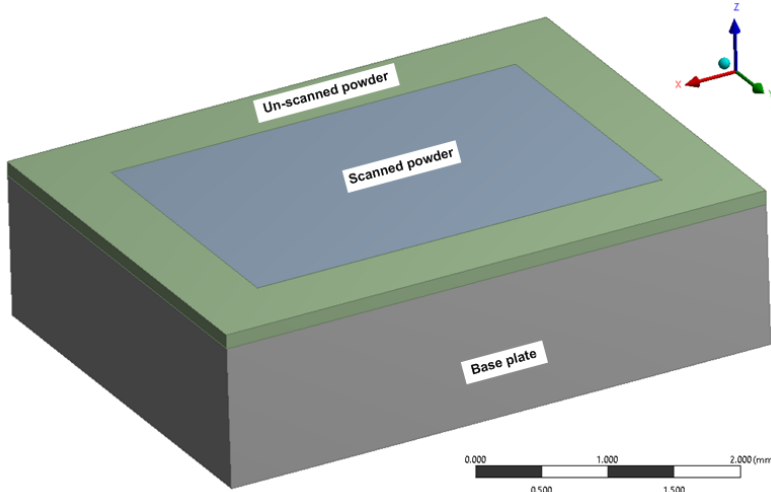
Figure 5. The model geometry used in the Figure 5 . The model geometry used in the analysis.